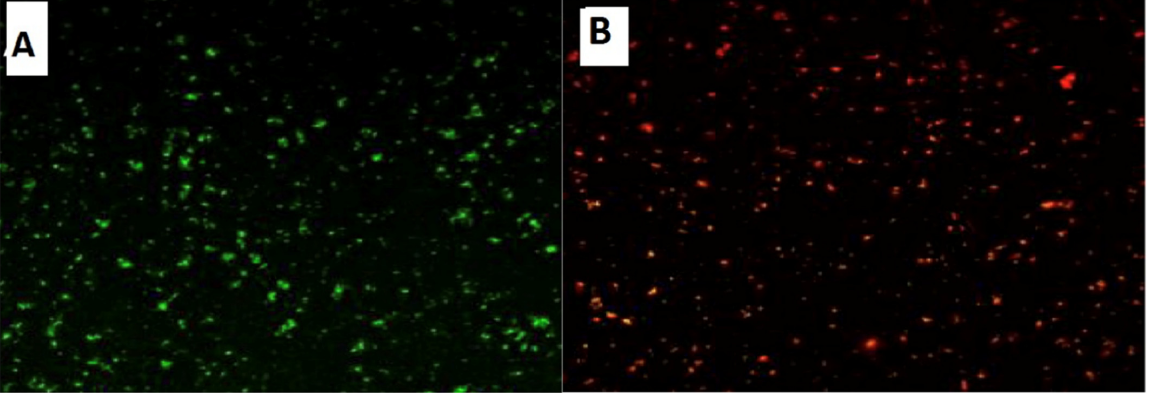
Figure 14. Confocal Scanning Laser Microscopy (CSLM) of mixed species Enterococcus faecalis and Streptococcus mutans ; before ( A ) and after treatment ( B ) with HAPNPs.